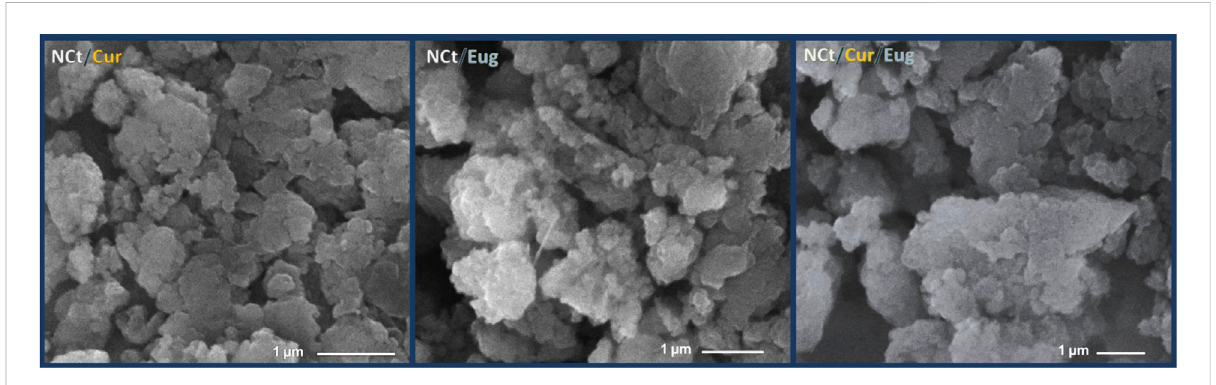
FIGURE 2 Scanning ultrastructures of synthesized nanocomposites from chitosan nanoparticles (NCt), curcumin (Cur), and eugenol (Eug).